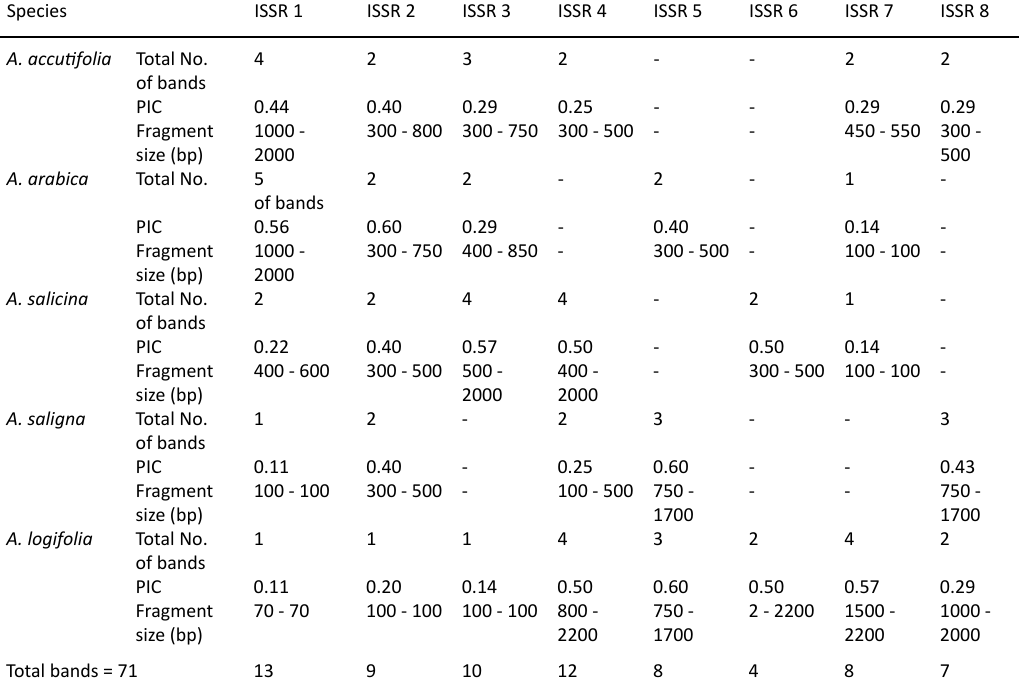
Table 4. Characteristics of total No. of bands, PIC, fragment size (bp), and total bands for ISSR markers amplification in Acacia